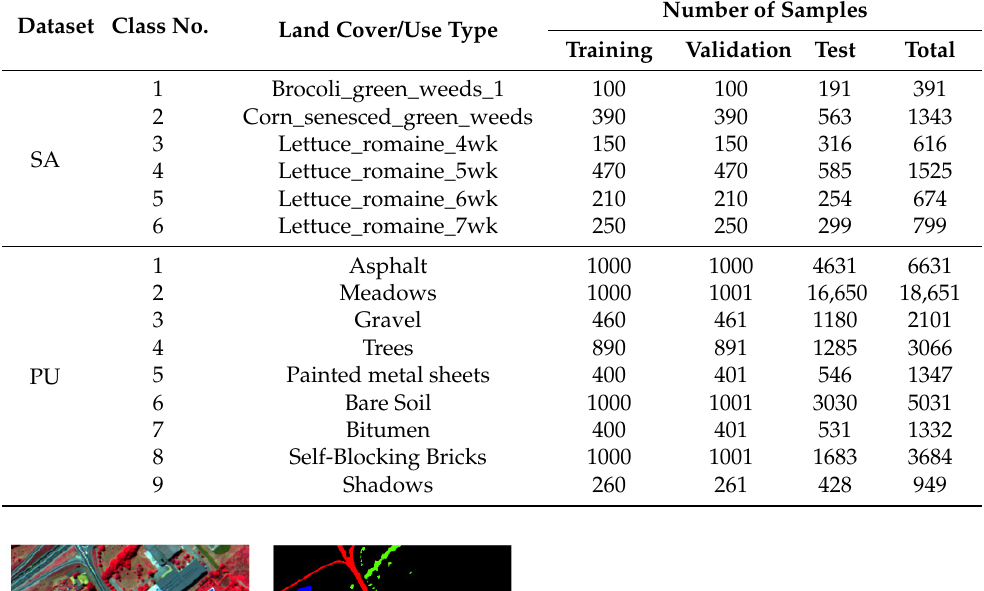
also shown in Table 1.